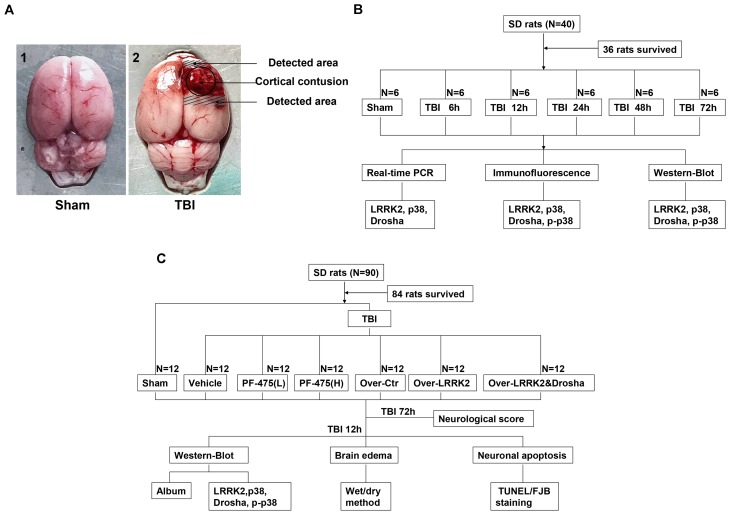
Experimental design. (A) Brain tissue from the peripheral injury (peri-injury) in the TBI group and from the same location in the sham group was obtained for the assay. (B) Experiment I was designed to demonstrate the expression levels and locations of LRRK2/p38/Drosha over time after TBI and determine a suitable time point for the second experiment. (C) Experiment II was designed to observe the effects of LRRK2 on early brain injury after TBI and explore the potential mechanisms.